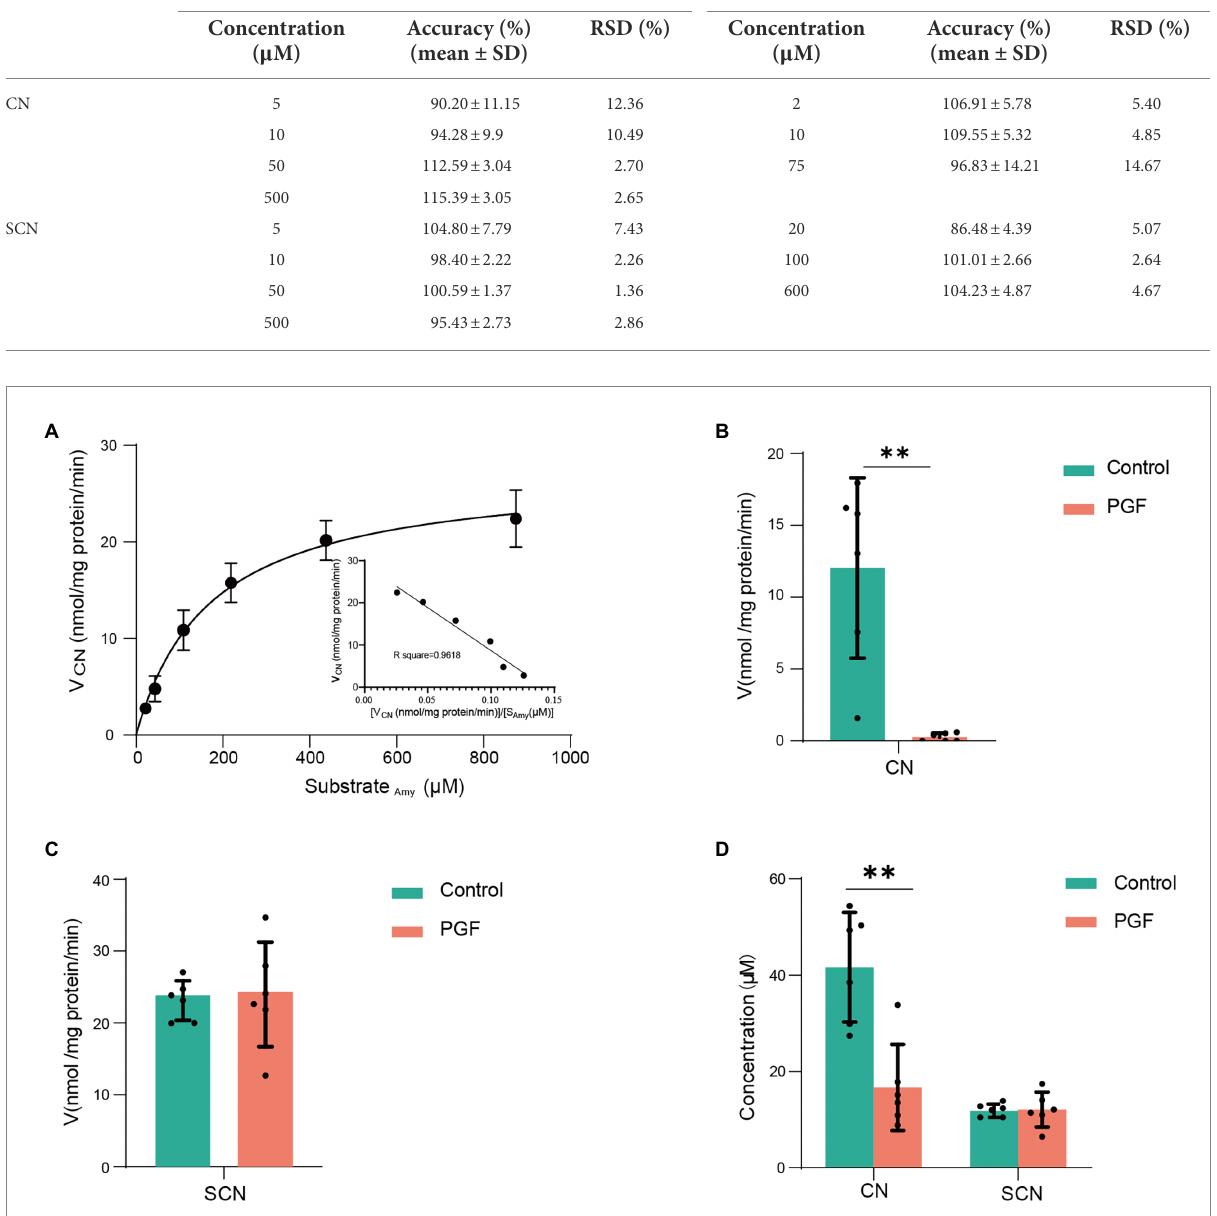
FIGURE 4 Enzyme kinetic characteristics of intestinal microbiota from the control and PGF groups. (A) Double Michaelis–Menten equation ( n = 4) for normal intestinal microbial enzyme kinetics, black dots denoted mean, and error bars denoted SD; (B) Generation rate of CN from amygdalin in the intestinal microbial enzyme system ( n = 6); (C) Generation rate of SCN from CN in the intestinal microbial enzyme system ( n = 6); (D) Final concentration of CN and SCN after incubating with 60 μ M of CN in the intestinal microbial enzymes ( n = 6). Data was shown as mean ± SD, black dots denoted samples, and the error bars denoted SD, * p < 0.05 and ** p <